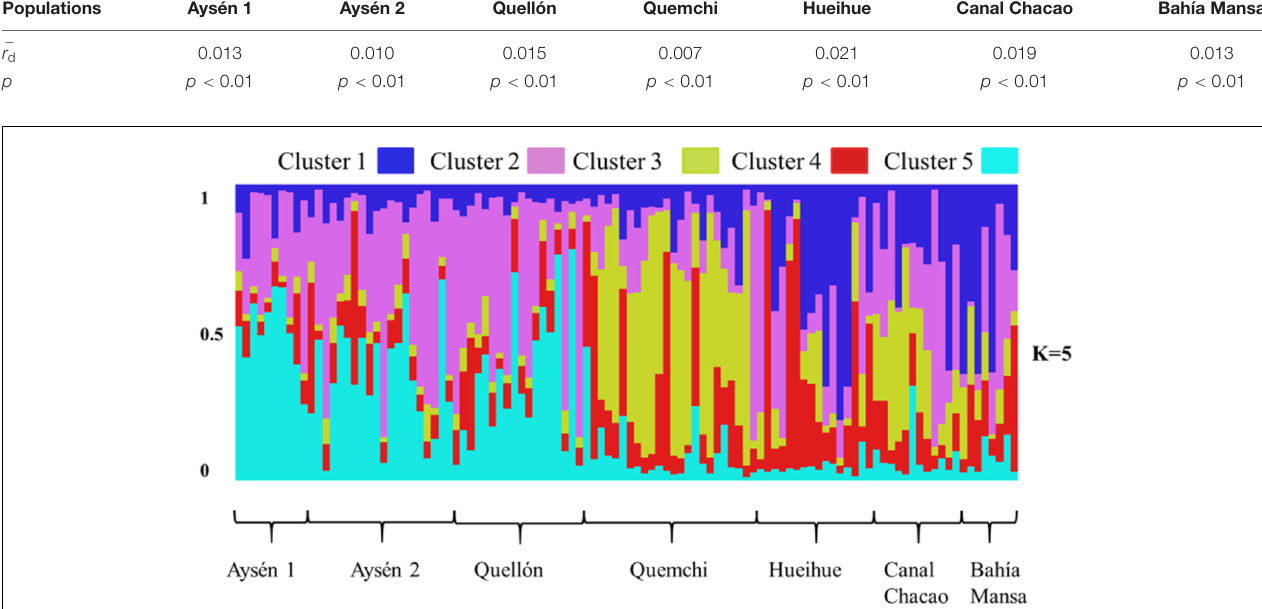
− r d per population and significance value ( p ).